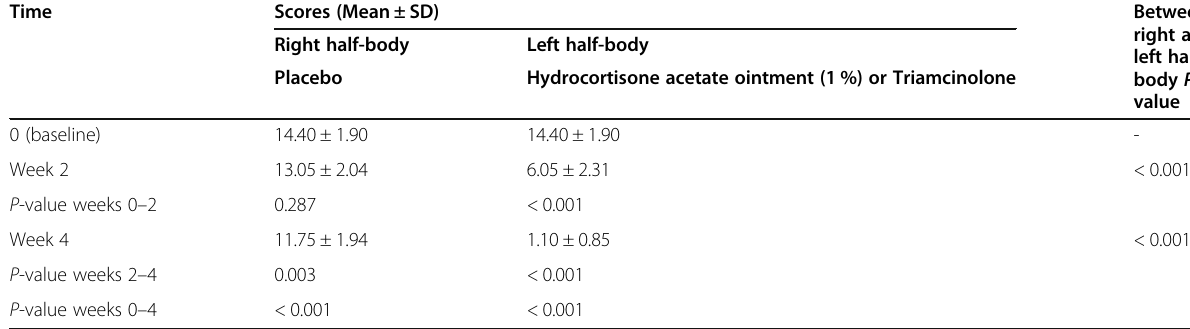
right and left half- body P -